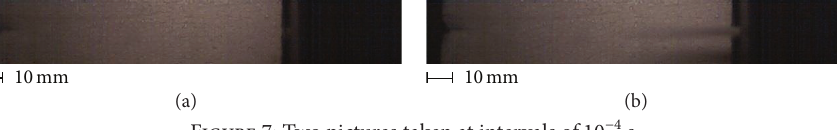
Figure 7: Two pictures taken at intervals of 10 −4 s.